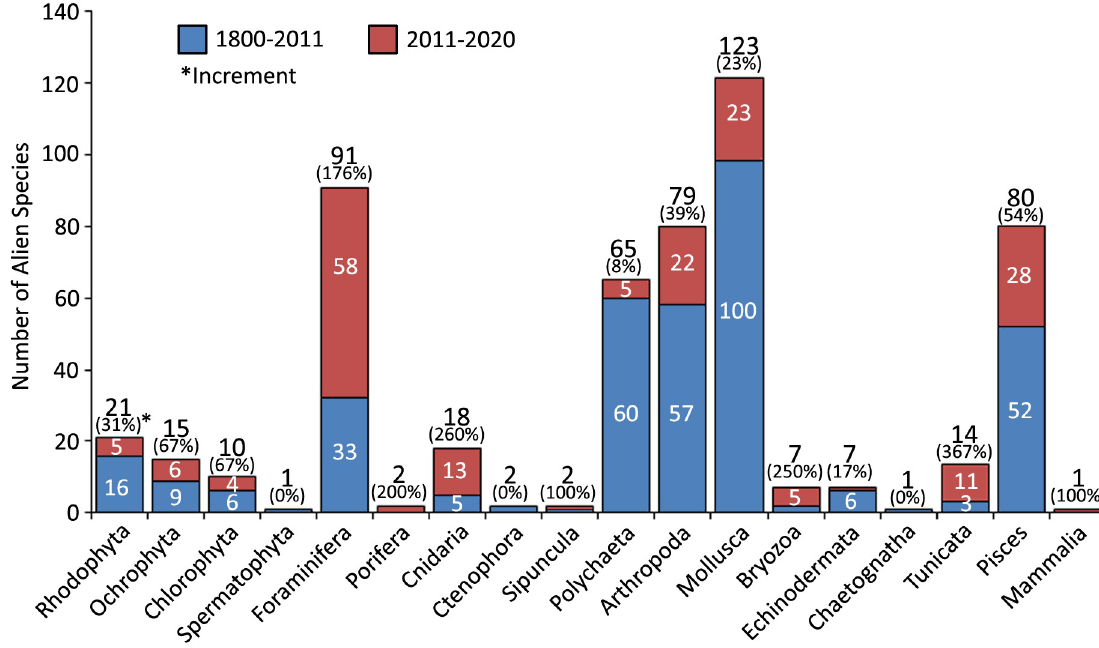
Fig 7. Changes in the number of alien species of taxonomic groups after the 2011’s species